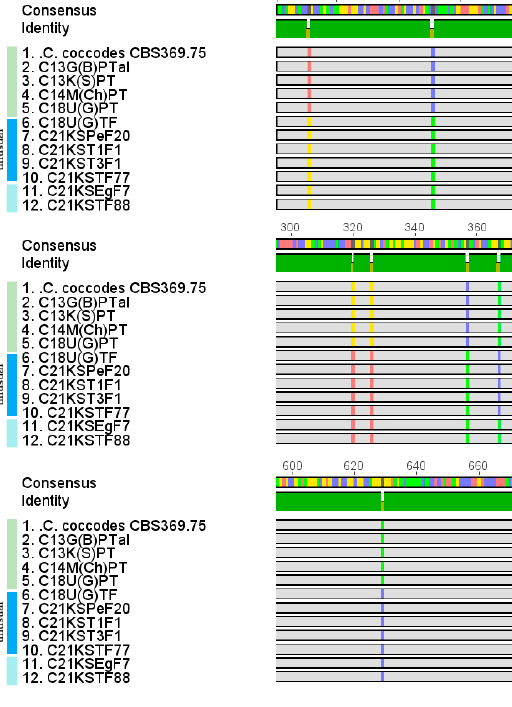
Figure 7. Comparison of glutamine synthetase second intron sequences of intriguing isolates (C18U(G)TF1/1, C21KST1F1, C21KST3F1, C21KSTF77, and C21KSPeF20) to type strain C. coccodes CBS 369.75. SNPs, including A, T, C, and G, are marked with red, green, blue, and yellow, respectively. Table 3. Comparison of intriguing isolates to type strains